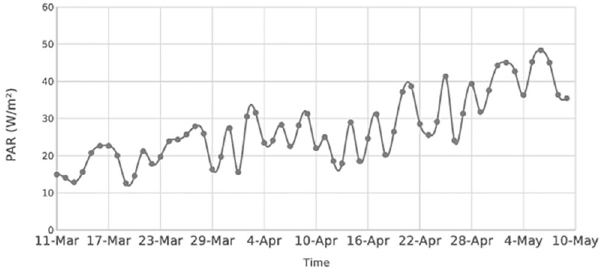
Fig 3. Daily average of photosynthetically active radiation (PARi) on the water surface under ice.